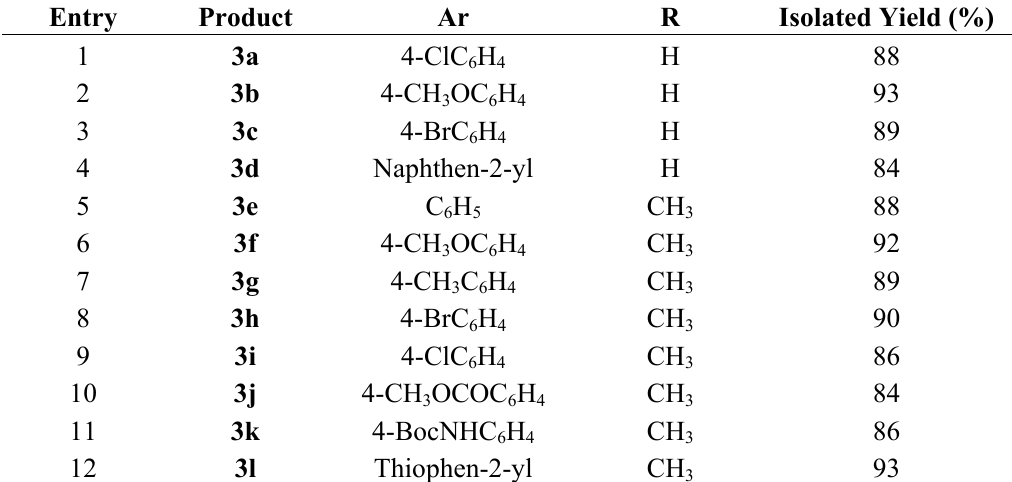
Table 1. The synthetic results of 5-arylisoxazole derivatives in aqueous